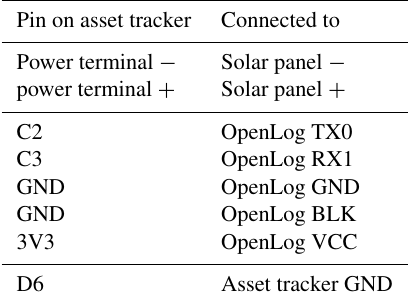
Table 2. Electrical connections between the particle asset tracker and the other components. Note that the connection between ground (GND) and OpenLog Black (BLK) can be made by connecting the OpenLog pins BLK and GND, saving the need for one wire. The connection between pin D6 and GND is to force the GPS unit on. See Fig. 1 for an image of the physical setup. Pin on asset tracker